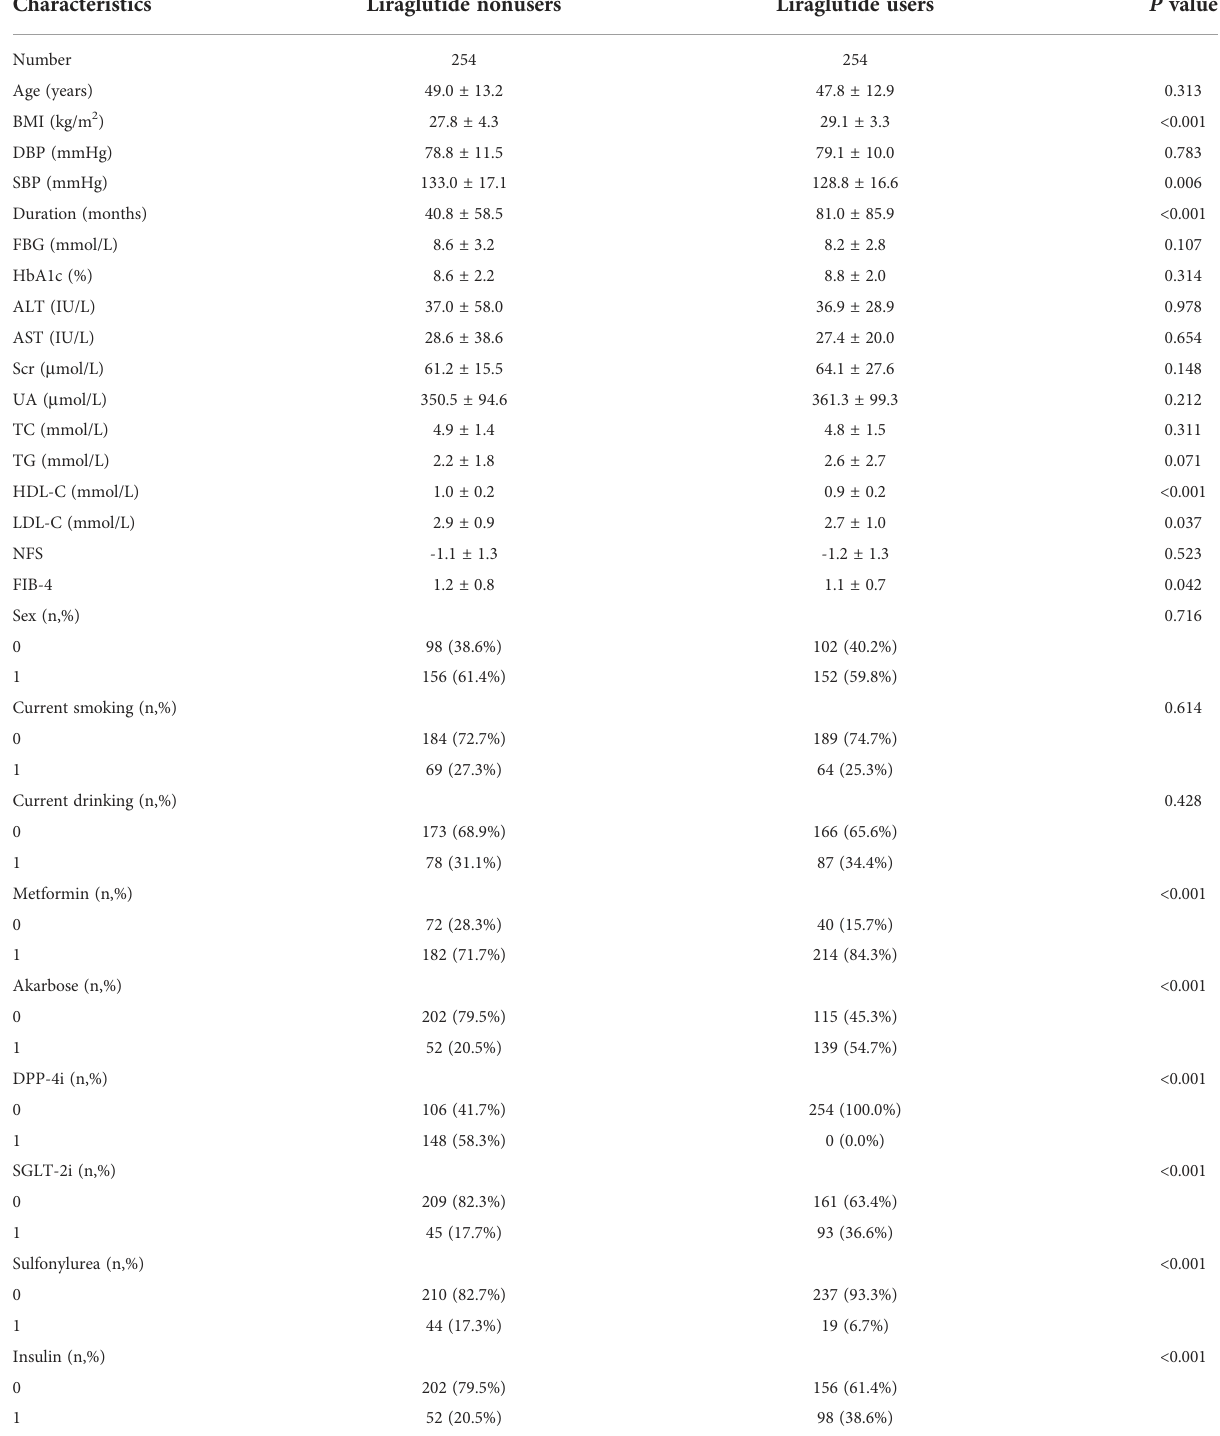
TABLE 2 Baseline data in the population according the use of GLP-1RAs after